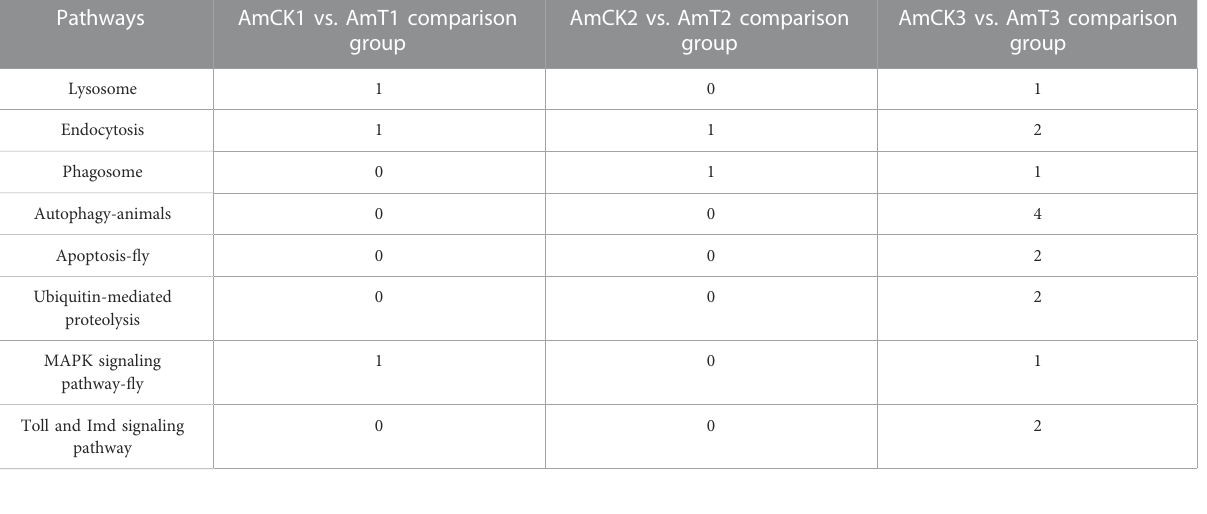
TABLE 2 Summary of immune-associated target DEmRNAs within ceRNA